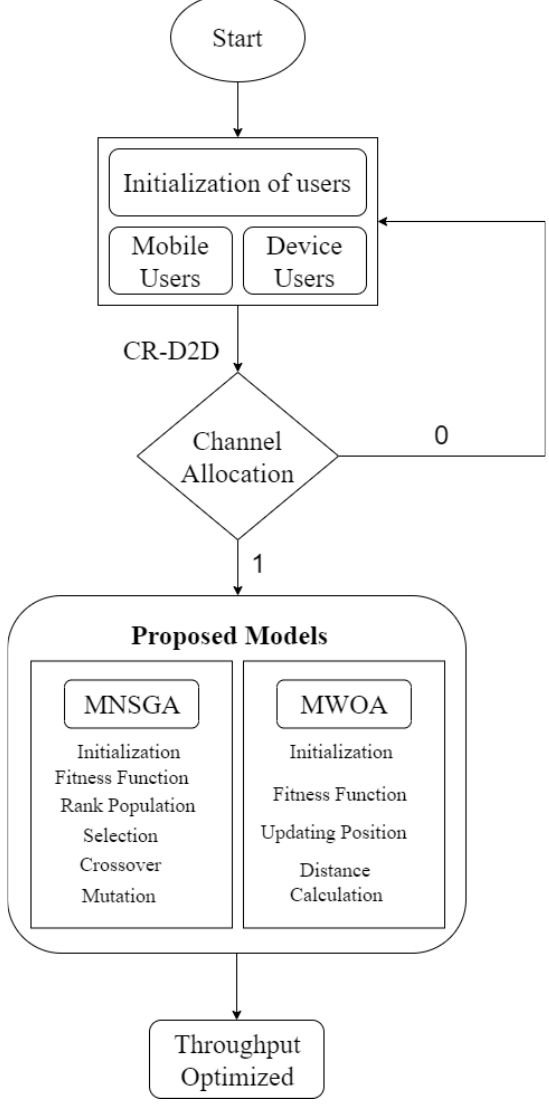
Figure 2. Proposed model.